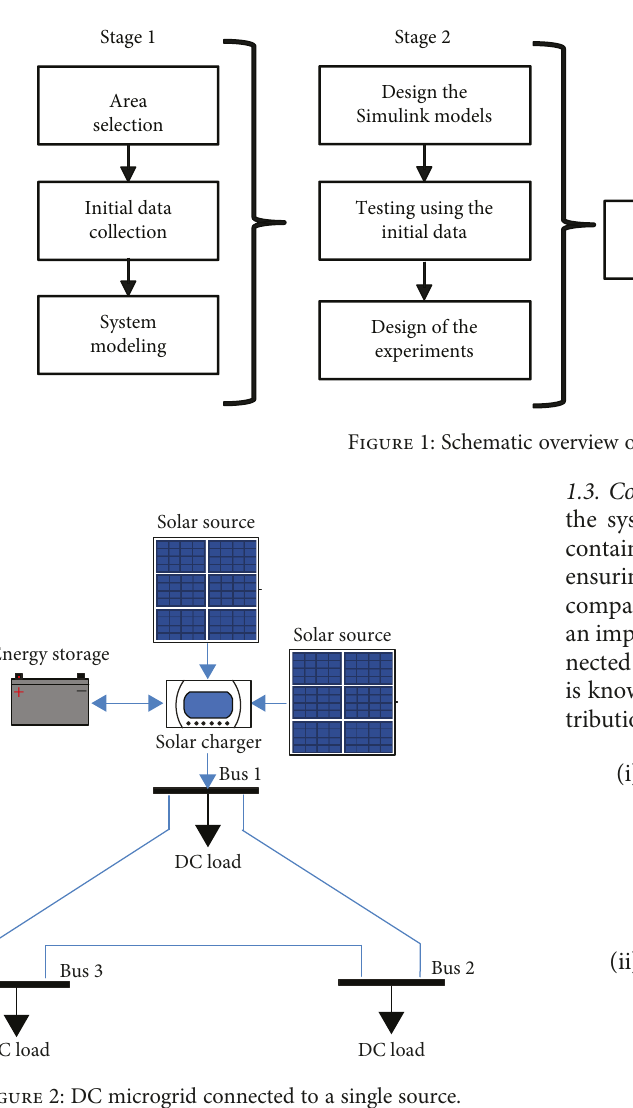
Figure 2: DC microgrid connected to a single